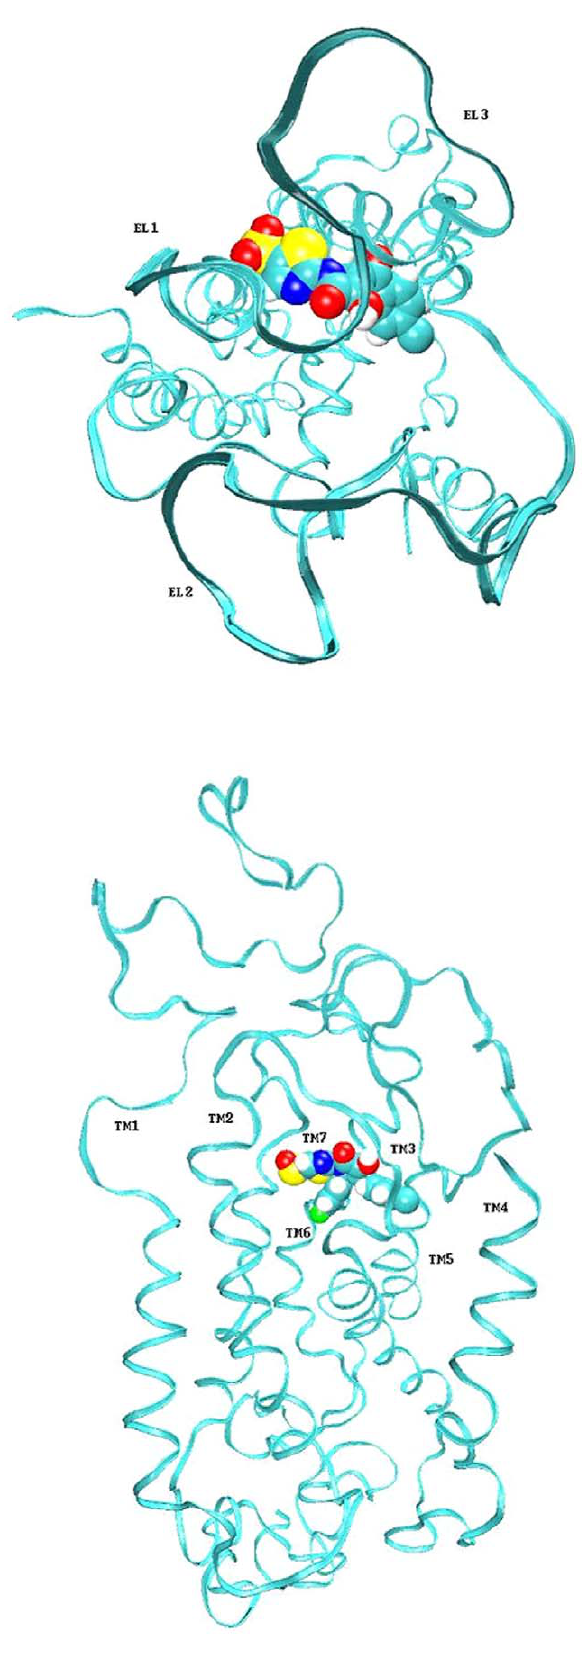
Figure 8. CB20 ligand docked into the CCR4 homology model.